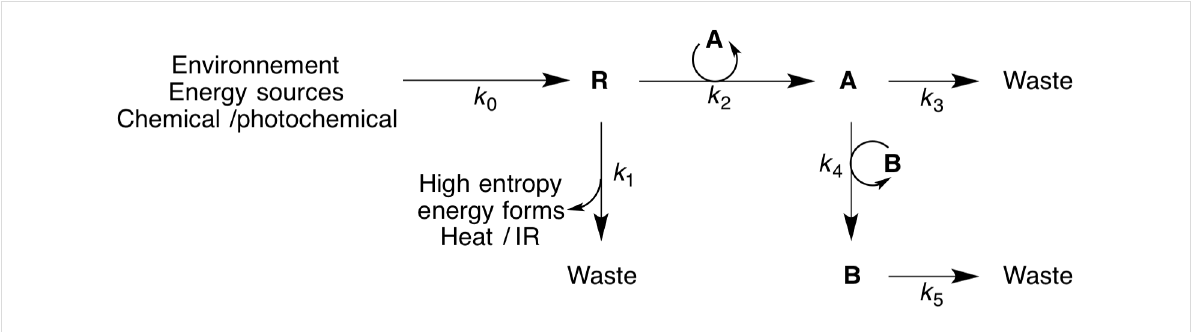
Figure 3: Evolution of an autocatalytic network involving a parasite. R : resource; A : autocatalyst; B : predator autocatalyst.